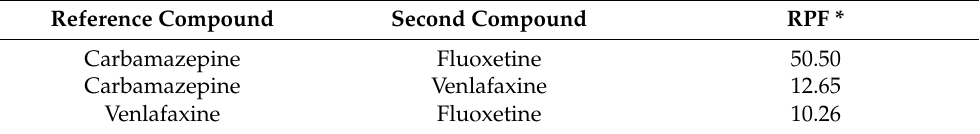
Table 2. RPFs of the three compound combinations used for designing the mixture